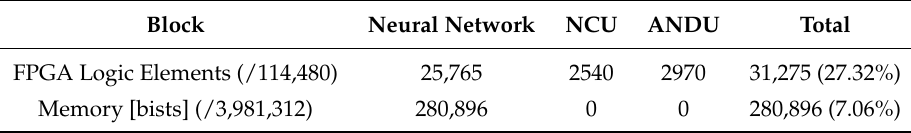
Table 1. Implementation results of the proposed hand gesture recognizer.